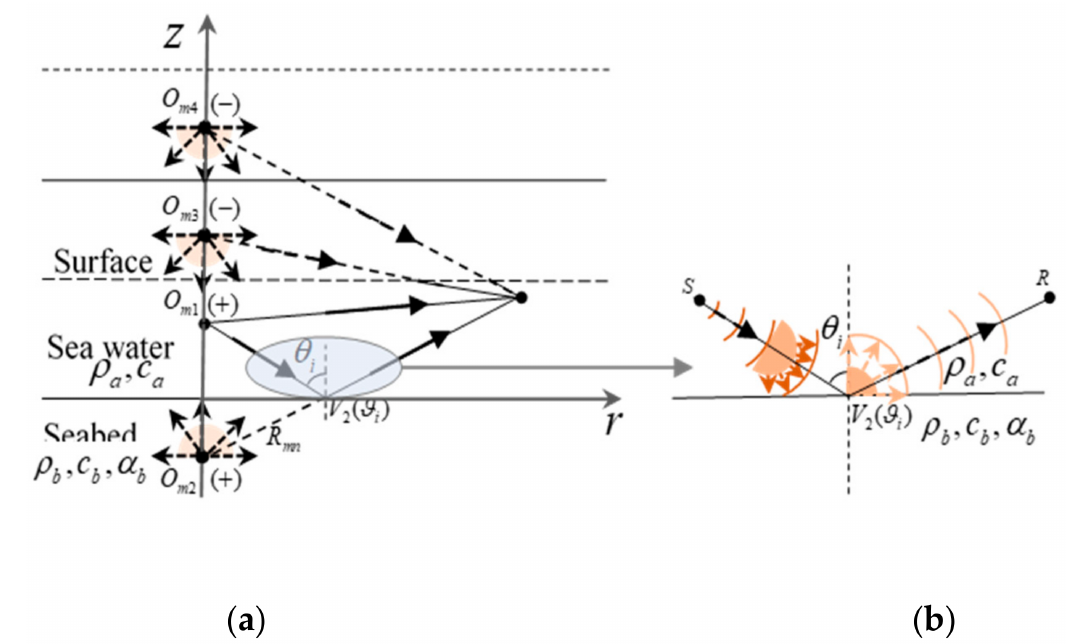
Figure 1. Schematic diagram of the Green’s function (GF) in shallow water: ( a ) the principle of the rigorous image source method (ISM); ( b ) sound reflection of spherical waves on the liquid–liquid